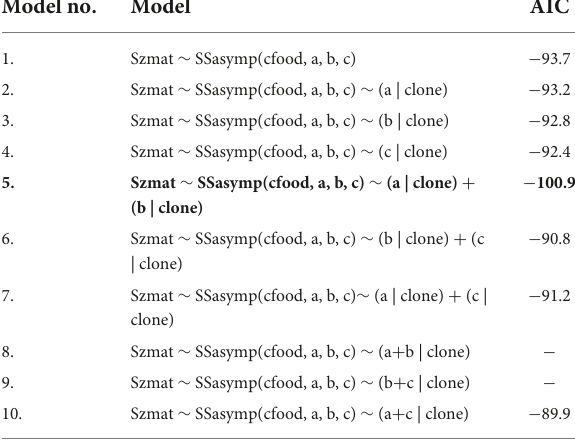
TABLE 3 Size at maturity reaction norm models, fitted using random regression mixed models (RRMM). Model no.